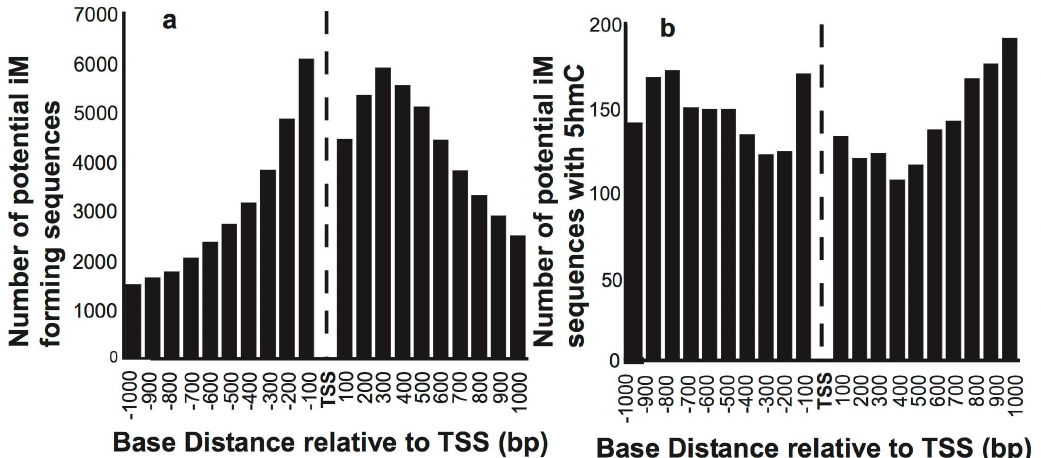
Figure 1. The overall distribution of the number of sequences that have putative iM-forming potential. ( a ) The number of sequences with putative iM potential and their position relative to the TSS of genes. ( b ) The number of putative iM-forming sequences that have 5hmCs co-localized within 100 bp of an iM relative to the TSS of genes.